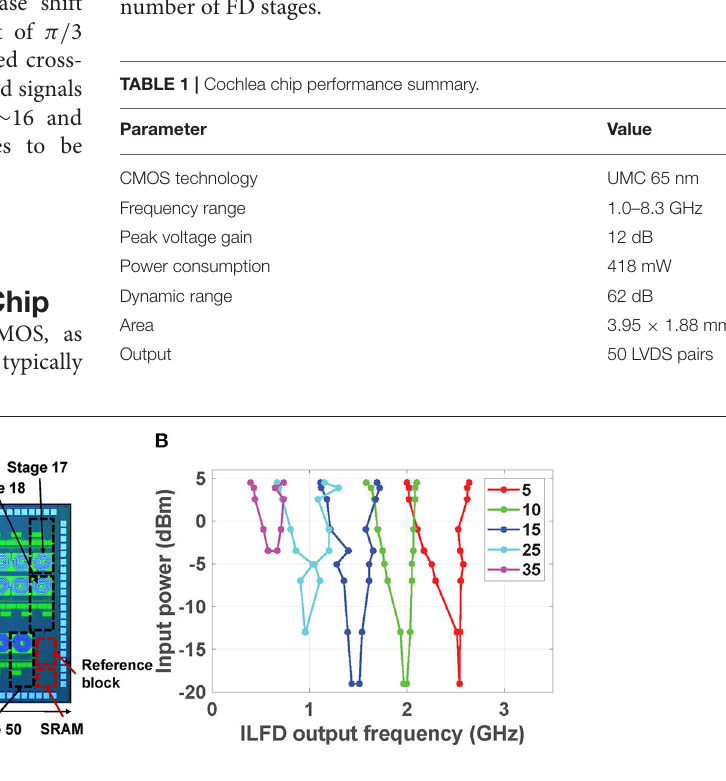
FIGURE 9 | (A) Die photograph of the digitally-programmable RF cochlea chip; and (B) measured input sensitivity curves for the frequency-encoded outputs at stages { 5,10,15,25,35 } (Wang et al., 2020).